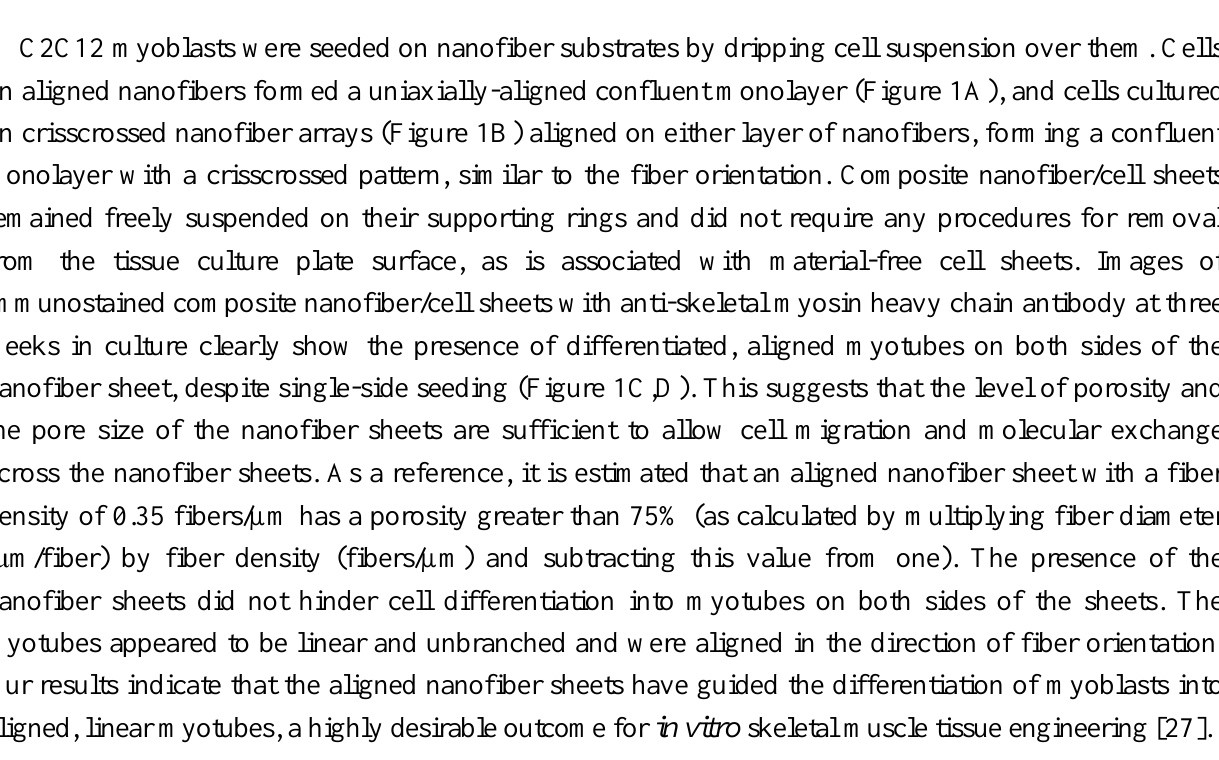
Figure 1. Fluorescent microscope images of C2C12 cell sheets grown on ( A ) uniaxially- aligned and ( B ) crisscrossed ultrathin nanofiber substrates for one week. Actin filaments were stained in green; nuclei were stained in blue. Confocal microscope images of a composite aligned nanofiber/cell sheet cultured for three weeks is shown in 2D ( C ) and reconstructed in 3D ( D ). Nanofibers (with a fiber density of 0.85 fiber/µm) are visualized in red, and myotubes are immunostained in green with skeletal myosin heavy chain. Thick